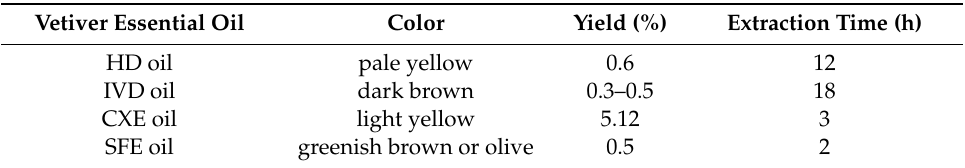
Table 2. General comparison of vetiver essential oils obtained from four di ff erent methods.